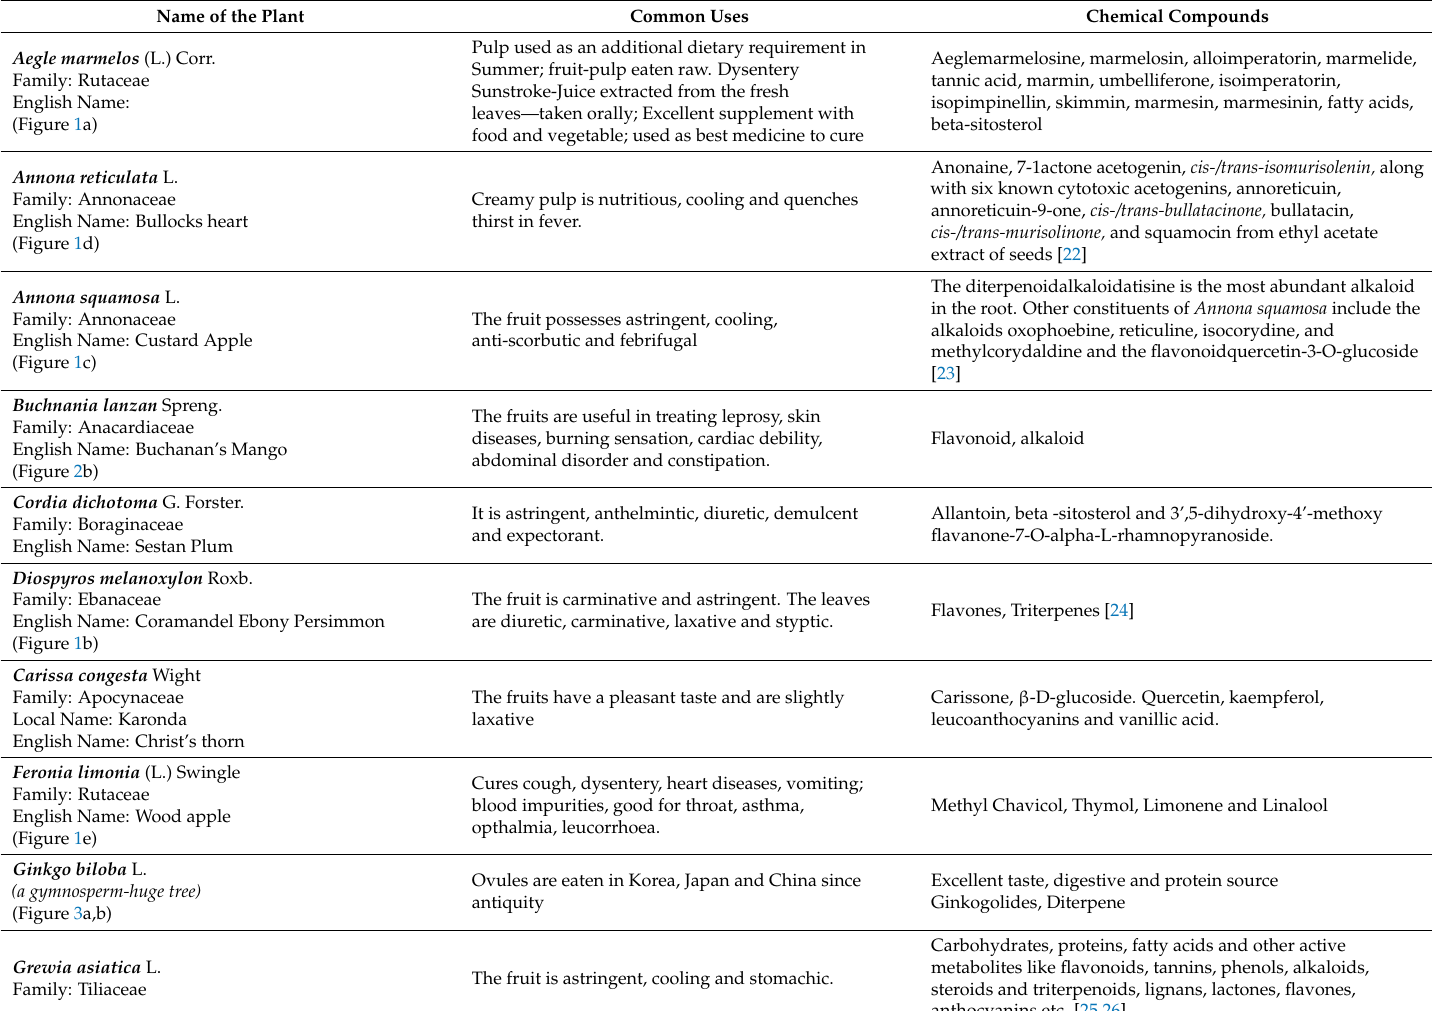
Table 1. Edible fruits on the trees in the wild and chemical compounds extracted from